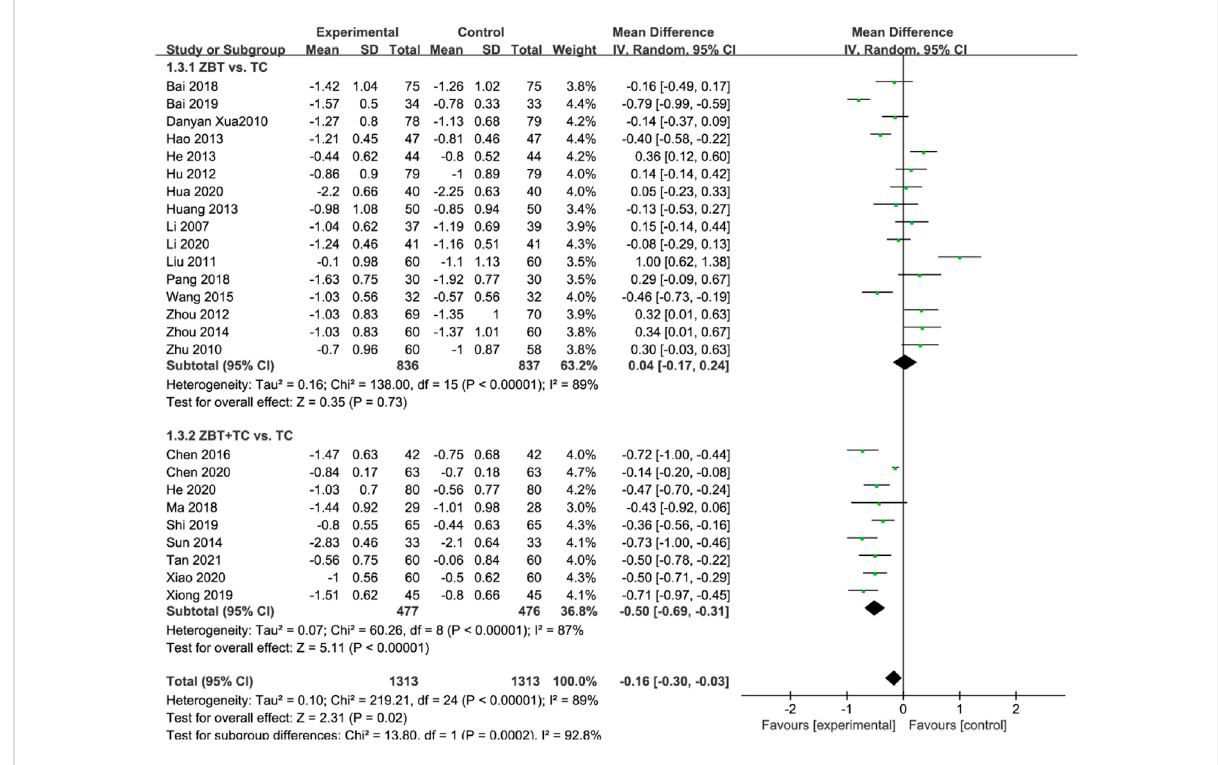
FIGURE 5 Meta-analysis results of the effect of Zhibitai (ZBT) vs. conventional therapy on low-density lipoprotein cholesterol (LDL-C).